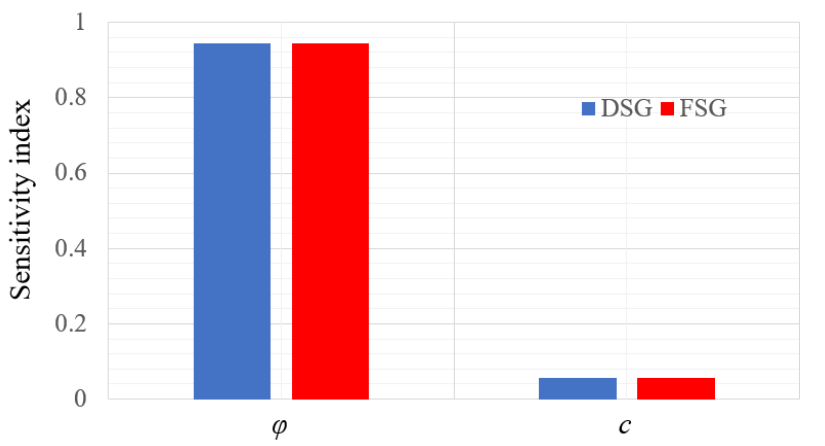
Figure 8. Sensitivity analysis results.